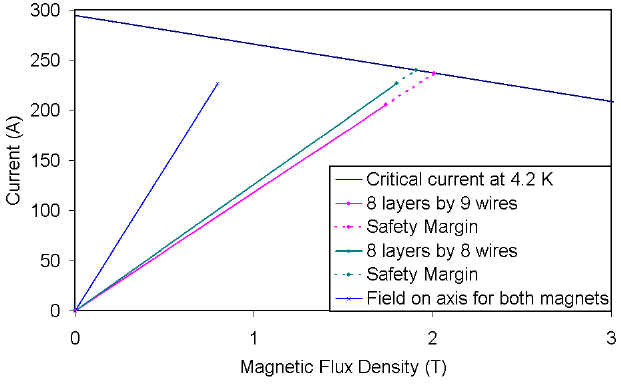
FIG. 8. (Color) Undulator conductor load lines, critical current at 4.2 K, and the field achieved on-axis.